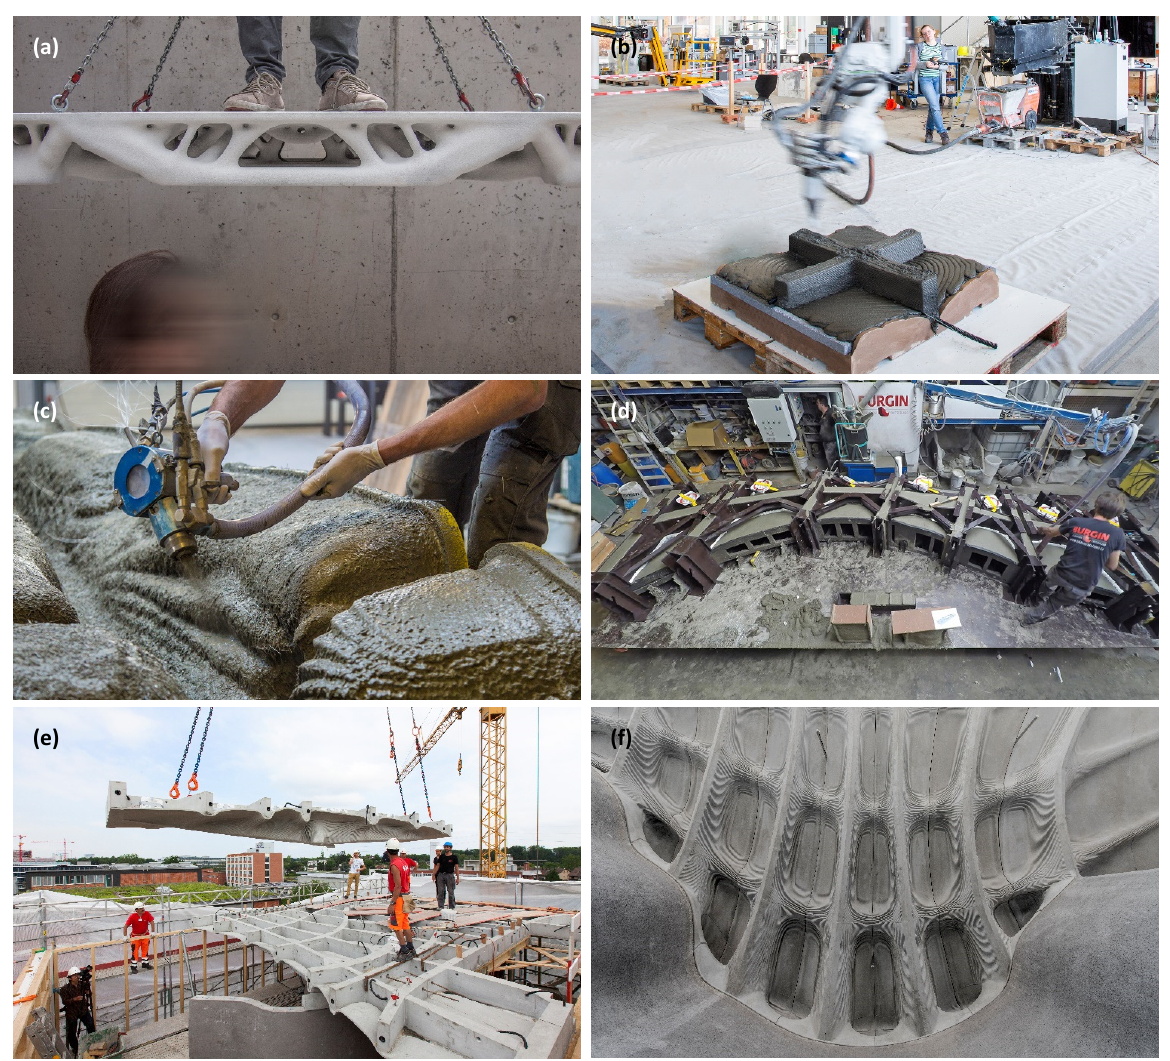
Figure 6. Ribbed slabs with binder jet 3D ‐ printed formwork: (a) stay ‐ in ‐ place formwork for the Smart Takes from the Strong [40]; (b) reusable formwork for Fast Complexity [41]; and (c ‐ f) disposable formwork for the DFAB HOUSE Smart Slab [31], illustrating (c) the spraying of the concrete cover, (d) the casting of the ribs, (e) the installation on ‐ site, and (f) the soffit of the finished slab.